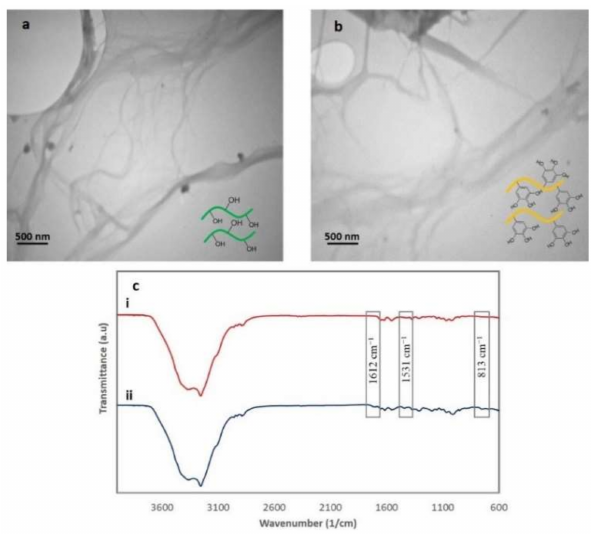
Figure1. TEMimageof( a )ChNFsand( b )TA-ChNFs; andFTIRresultsof( ci )ChNFsand( cii